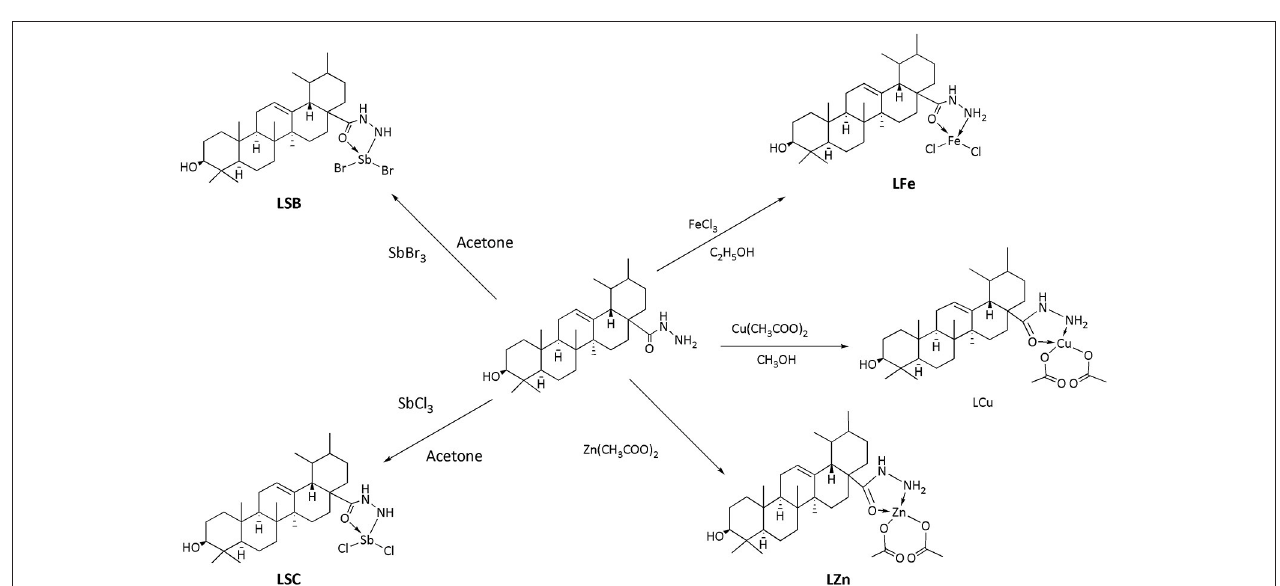
FIGURE 2 | Synthesis of Cu, Fe, Zn and Sb